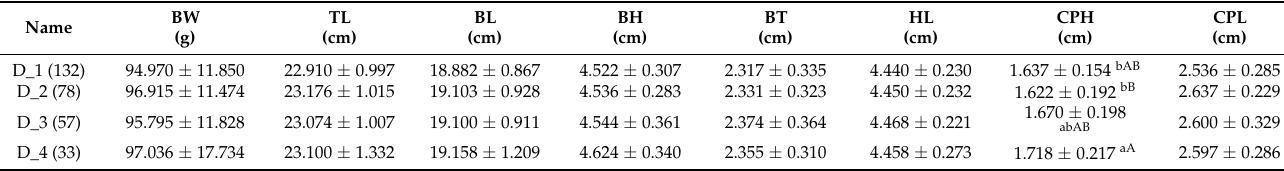
Table 4. Association analysis of diplotypes and growth traits in striped catfish. Note: The data are presented as mean ± SD. For each growth trait of the same diplotype, different lowercase letters indicate significant differences ( p < 0.05) and different capital letters indicate extremely significant differences ( p <